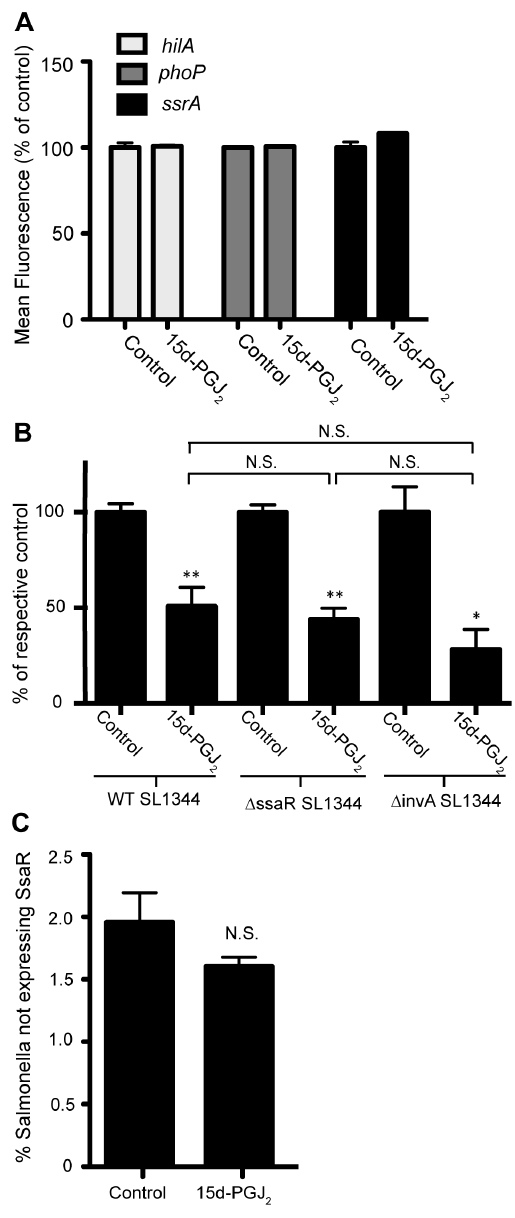
Figure 6. Expression of Salmonella virulence genes are unaf- fected by 15d-PGJ 2 treatment. ( A ) Wild-type Salmonella carrying hilA- , phoP- , and ssrA-gfp reporter transcriptional fusions were used to analyze the effect of 15d-PGJ 2 on virulence gene expression. Cultures were grown in LB for 4 hours. No changes in expression were seen. ( B ) 15d-PGJ 2 reduced bacterial colonization of macrophages by the wild- type Salmonella strain, the D ssaR strain, and the D invA strain. Data are expressed as a percentage of the respective control samples, to illustrate that the extent of the inhibition caused by 15d-PGJ 2 is equivalent in both strains. ( C ) Flow cytometry analysis of ssrA gene expression in Salmonella after infection of RAW264.7 macrophages with or without 15d-PGJ 2 treatment. Averages of 8 measurements are shown with standard errors of means. (*p , 0.05, **p ,